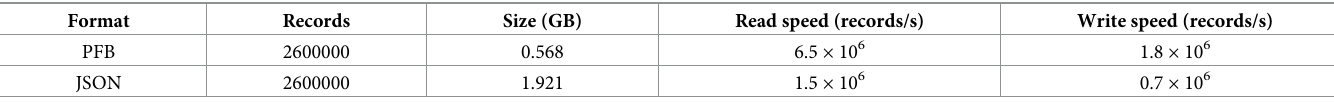
Table 6. Read/write speed comparison between PFB and JSON from/to